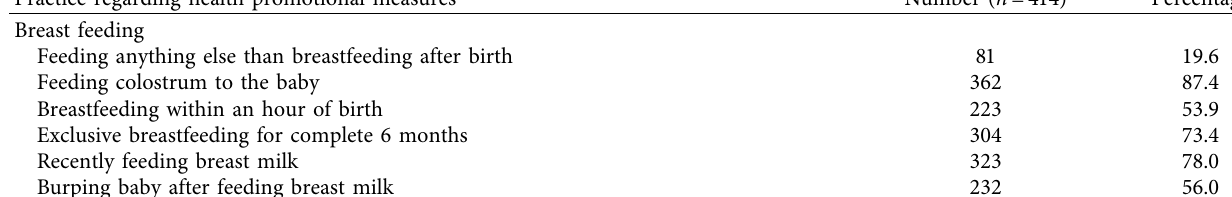
Complementary feeding Started complementary feeding with lito, mashed cereals, and fruits Continuation of breast feeding with complementary feeding